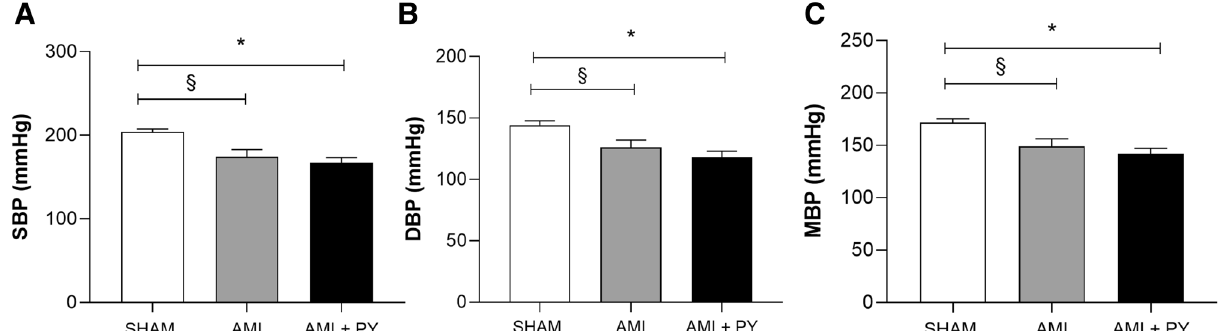
Figure 1. Hemodynamic parameters. ( A ) SBP; Systolic Blood Pressure. ( B ) DBP; Diastolic Blood Pressure, and ( C ) MBP; Mean Blood Pressure; HR: Heart rate. * p < 0.05 versus Sham; § p < 0.05 versus AMI. Values expressed as mean ± SEM. Statistical significance was determined by one-way ANOVA followed by a multiple comparisons test Tukey’s was performed using GraphPad Prism version 9.0.1. www. graph pad. com.